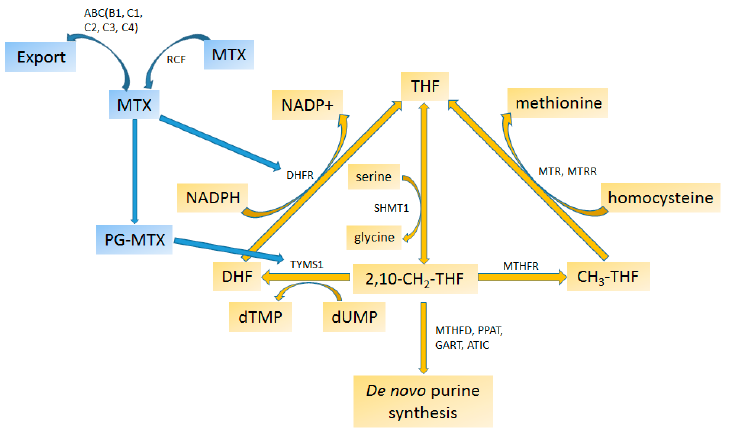
Figure 3. Functioning of Methotrexate. Metabolite : Dihydrofolate (DHF), Methotrexate (MTX), Methotrexate polyglutamate (PG-MTX), Methyl-tetra-hydrofolate (CH 3 -THF), Methylene-tetra- hydrofolate (2,10-CH 2 -THF), Nicotinamide adenine dinucleotide phosphate (NADP), Tetrahydrofolate (THF), Thymidine monophosphate (dTMP), Uridine monophosphate (dUMP). Enzyme : ATP binding cassette subfamily B1, C1, C2, C3, C4, (ABCB1, ABCC1, ABCC2, ABCC3, ABCC4,), Dihydrofolate reductase (DHFR), serine hydroxymethyltransferase 1 (SHMT1), Formyltetrahydrofolate synthetase (MTHFD), Methylenetetrahydrofolate reductase (MTHFR), Phosphoribosyl pyrophosphate amidotransferase (PPAT), Phosphoribosylglycinamide synthetase (GART), Replication factor C subunit 1 (RFC), Thymidylate synthase (TYMS1), 5-aminoimidazole-4- carboxamide ribonucleotide formyltransferase/IMP cyclohydrolase (ATIC), 5-methyltetrahydrofolate- homocysteine methyltransferase (MTR), 5-methyltetrahydrofolate-homocysteine methyltransferase reductase (MTRR). Colors: blue—active drug or metabolite; golden—endogenous metabolite (adapted from [22,207]).